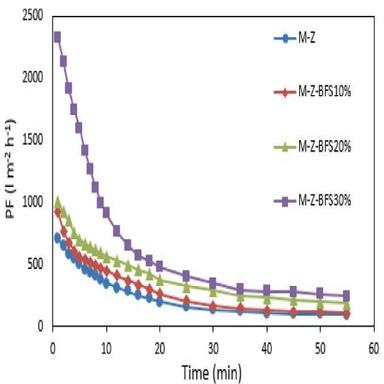
Flux over filtration time of the oily wastewater on M-Z, M-Z-BFS10, M-Z-BFS20 and M-Z-BFS30 membrane.